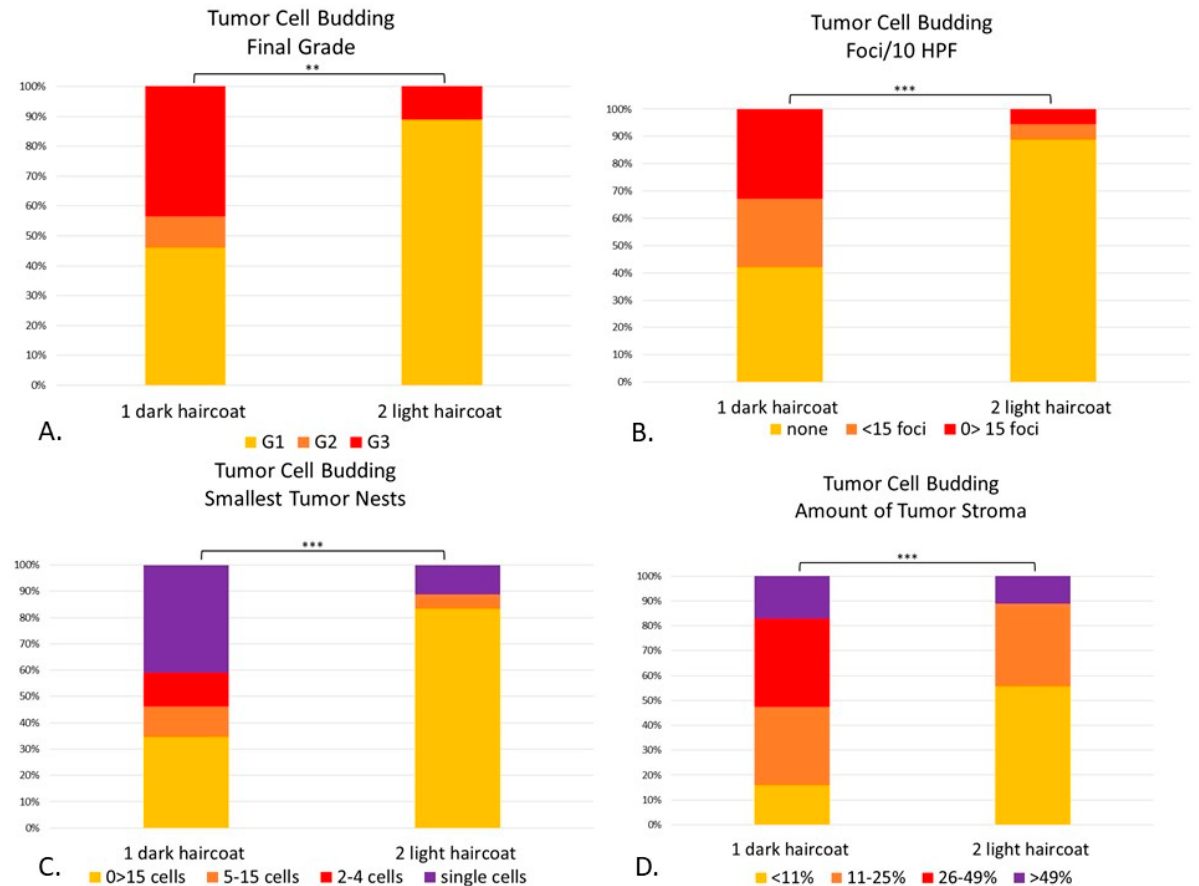
Figure 9. ( A – D ). Canine digital squamous cell carcinoma. Statistical differences between phenotypically dark-haired (Group 1) and light-haired (Group 2) dogs according to the tumor cell budding system. There were statistical differences between Groups 1 and 2 in final grade ( p < 0.01) ( A ), tumor cell budding in 10 HPF ( p < 0.001) ( B ), smallest tumor nest size ( p < 0.001) ( C ) and amount of tumor stroma ( p < 0.001) ( D ). ** p < 0.01; *** p < 0.001.